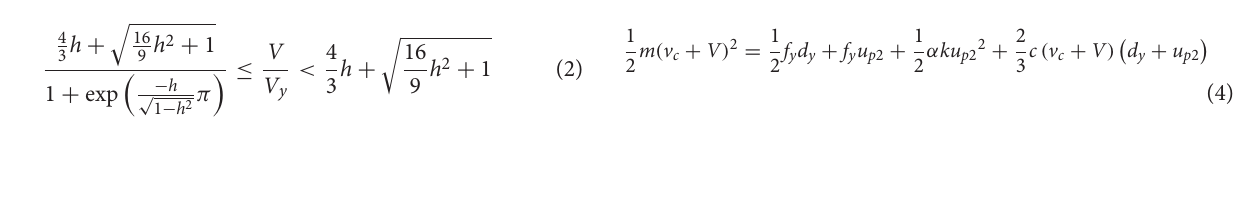
Collapse Pattern 1: Collapse limit after the second impulse The left-hand side of the above inequality indicates the input velocity level at which the damped bilinear hysteretic SDOF system just attains the yield deformation after the second impulse and the right-hand side corresponds to the input velocity level at which the SDOF system just attains the yield deformation after the first impulse.